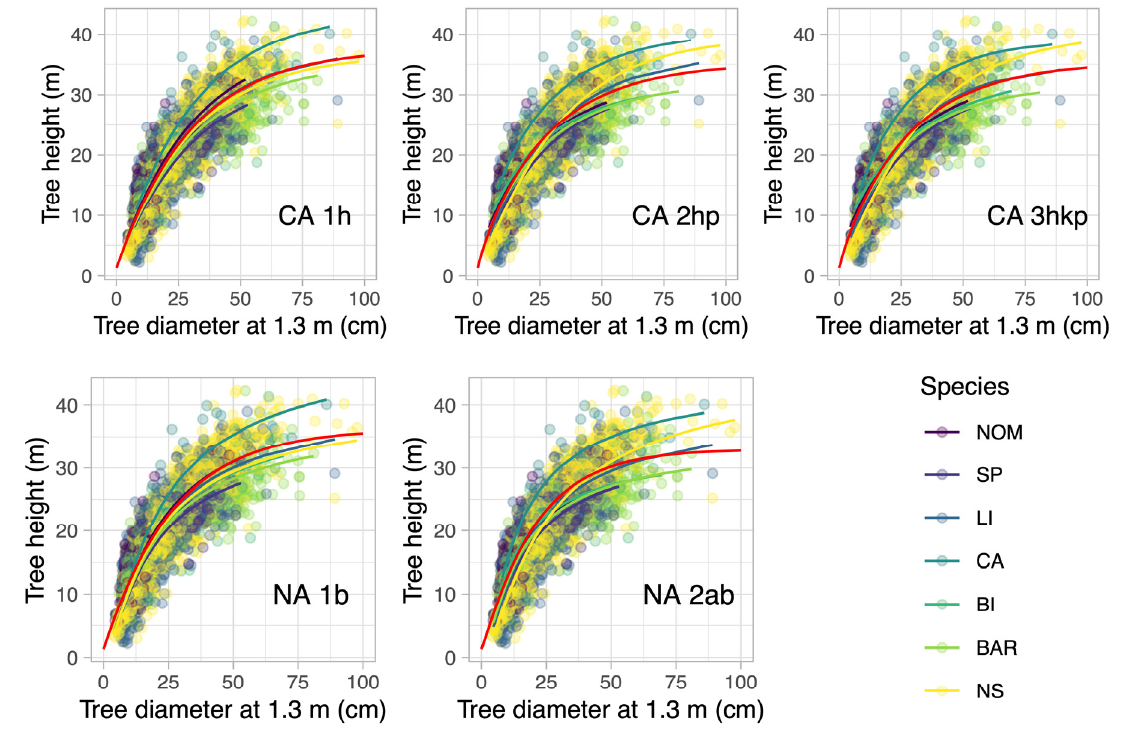
Figure 2. Mixed-effects models for the dataset of the unmanaged old-growth forest in Järvselja. Chapman–Richards models are denoted by CA and a number–letter combination that denotes the number of parameters and which parameter was included in the random effects. For 1, the parameters h mx , for 2, the parameters h mx and p , and for 3, the parameters p , k and h mx were included in the random effects. In the case of the Näslund model, we use NA, and number 1 means that parameter b was included in the random effects and number 2 that both parameters, b and a, were included in the random effects. Data are given as symbols and modeled relationships as lines. The colors refer to each species used in the fitting procedure where the dots are data and the lines the fitted model results per species. The red line denotes the overall relationship found using the nonlinear mixed-effects model fit. Tree species are as follows: BI = silver birch and downy birch; NS = Norway spruce; BAR = black alder; SP = Scots pine; LI = lime family; NOM = Norway maple; CA = common aspen.